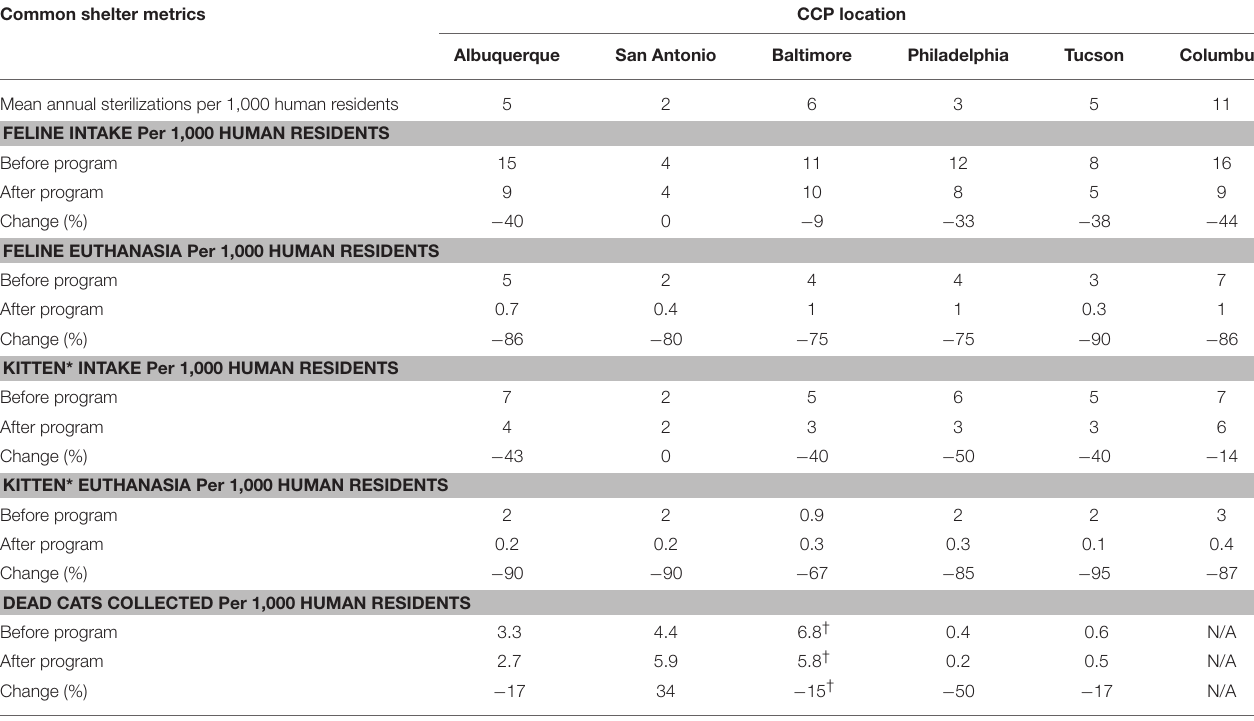
TABLE 6 | Impact of CCPs on shelter feline intake and euthanasia per 1,000 human residents. Common shelter metrics